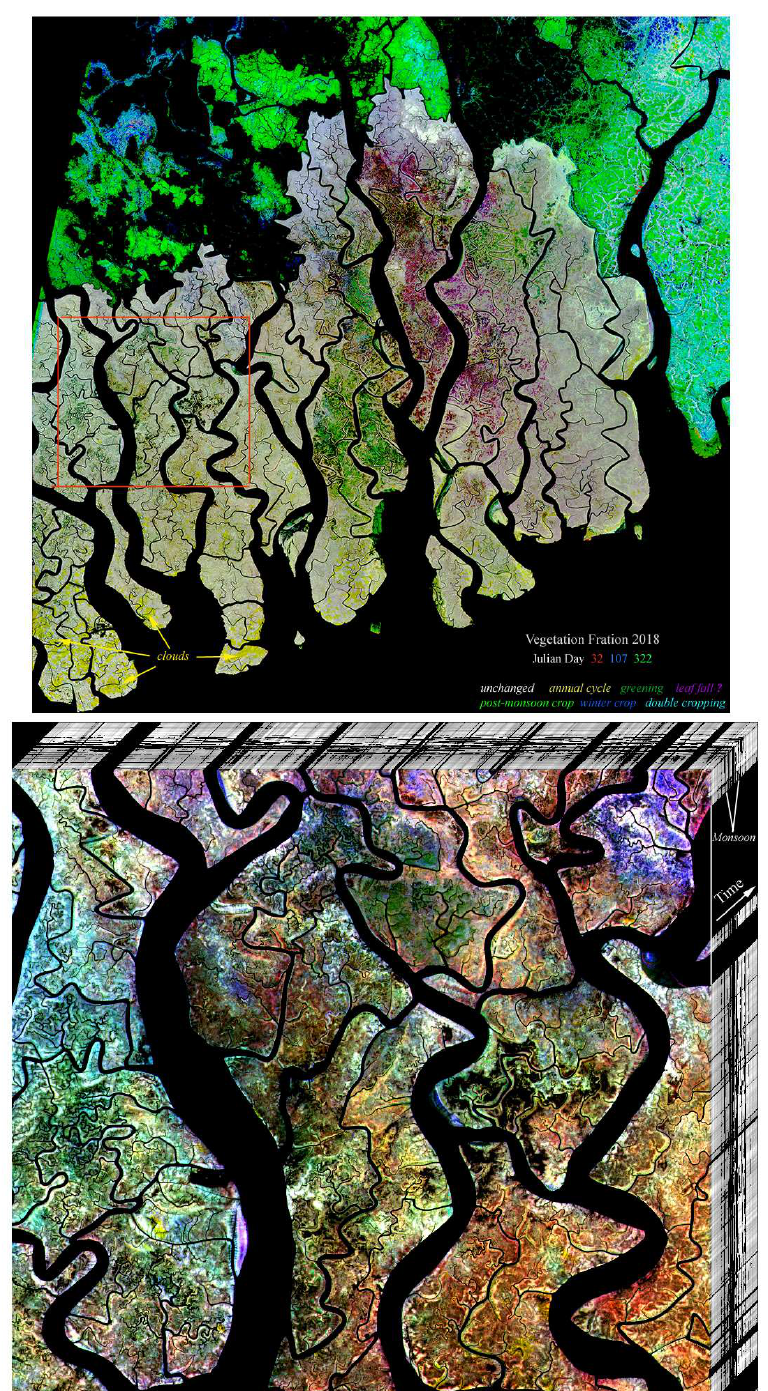
Figure 4. Tri-temporal vegetation maps. HLS Sentinel 2 vegetation fractions from julian days 32 (r), 107 (b) and 322 (g) of 2018 with common linear stretch (top) show spatially coherent seasonal greenness variations of ± 20% in mangroves and much larger changes in agricultural fields. A 10 x10 km substack from western edge (inset & bottom) shown as a spatiotemporal cube has more subdued, but still spatially coherent, temporal greenness variations on tri-temporal composite (front of cube) while seasonal progression of 69 HLS vegetation fraction maps (top & right edges) clearly show variations in post-monsoon greening. The Gaussian stretch of the tri-temporal substack reveals even finer scale coherent variations in seasonal